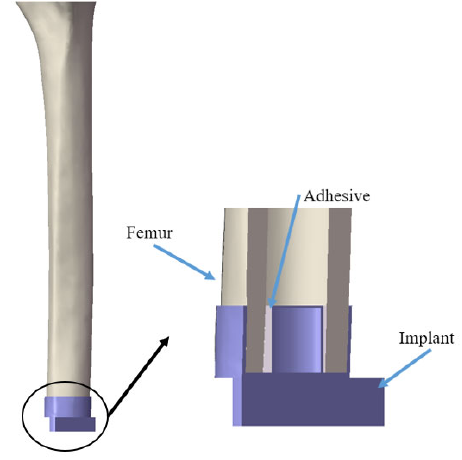
Figure 2. Cross ‐ section of femur–implant interface with adhesive epoxy. Figure 2. Cross-section of femur–implant interface with adhesive epoxy.